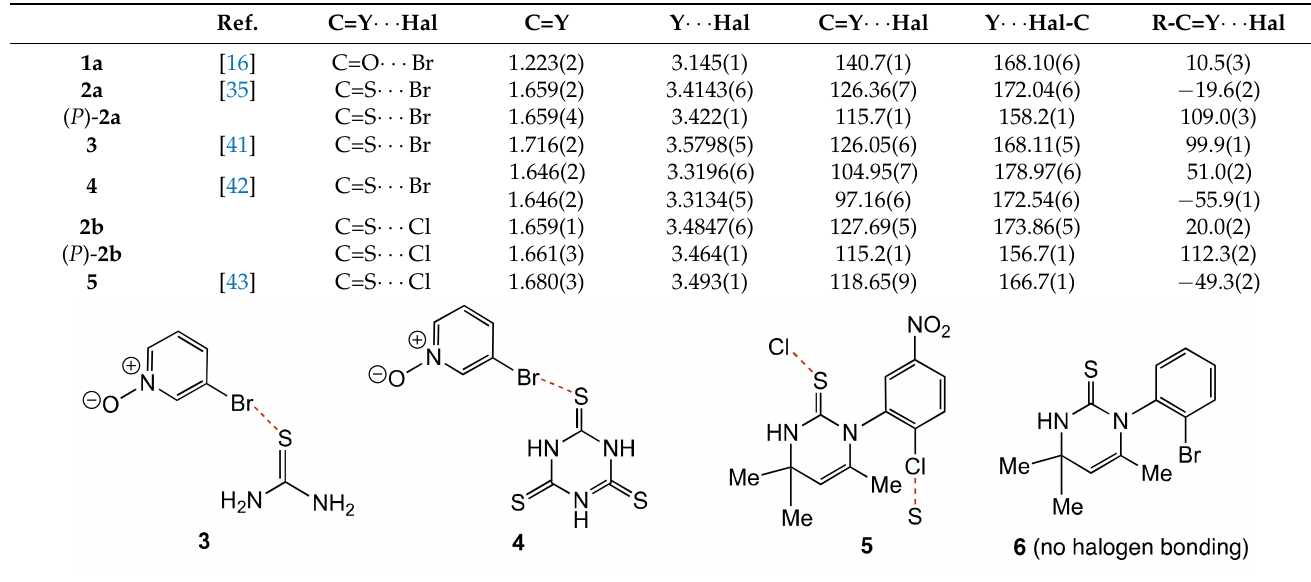
Figure 4. A part of the packing structure of ( P )- 2a at 100 K with 50% probability thermal ellipsoids. The comparative distances and angles of the detected and previously reported halogen bonds are summarized in Table 2. The intermolecular halogen bonds (C=S · · · Br) between achiral substrates, e.g., thiourea and 3-bromopyridine- N -oxide ( 3 , CCDC1979836) or trithio- cyanuric acid and 3-bromopyridine- N -oxide ( 4 , CCDC2011097) have been previously reported [41,42]. The halogen bond in 3 is oriented orthogonally toward the thiocarbonyl plane [the torsion angle of N-C=S · · · Br is 99.88 ◦ ] like ( P )- 2a , while the torsion angle of N-C=S · · · Br in 4 was 50.95 ◦ and − 55.90 ◦ . The bond angles of S · · · Br-C in 3 and 4 are 168.11 ◦ and 172.54–178.97 ◦ , respectively and these values are similar to that (172.04 ◦ ) of racemic 2a . Although the magnitude of the shortening (2.0%) of halogen bonds in 3 (the distance of S · · · Br is 3.580 Å) was smaller than those (6.5 and 6.2%) in racemic 2a and ( P )- 2a, those (9.1 and 9.3%) in 4 (the distances of S · · · Br are 3.320 and 3.313 Å) were significantly larger in comparison with those in 2a. Table 2. The distances (Å), bond angles ( ◦ ) and torsion angles ( ◦ ) of short non-hydrogen intermolecu- lar contacts for 1a , 2a – b , and 3 – 5